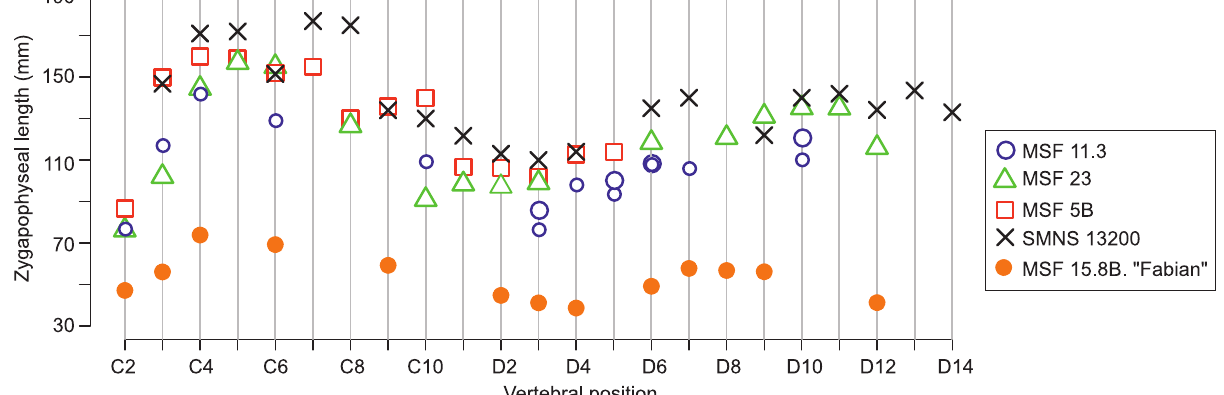
Fig. 13. Comparative plot of zygapophyseal lengths of Plateosaurus neural arches. Note size difference between large juvenile (MSF 15.8B.) and adult neural arches described by Hofmann and Sander